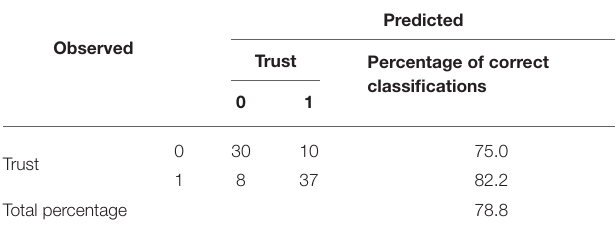
TABLE 6 | Percentage of correct classifications in the training data for the dependent variable “attractiveness”.